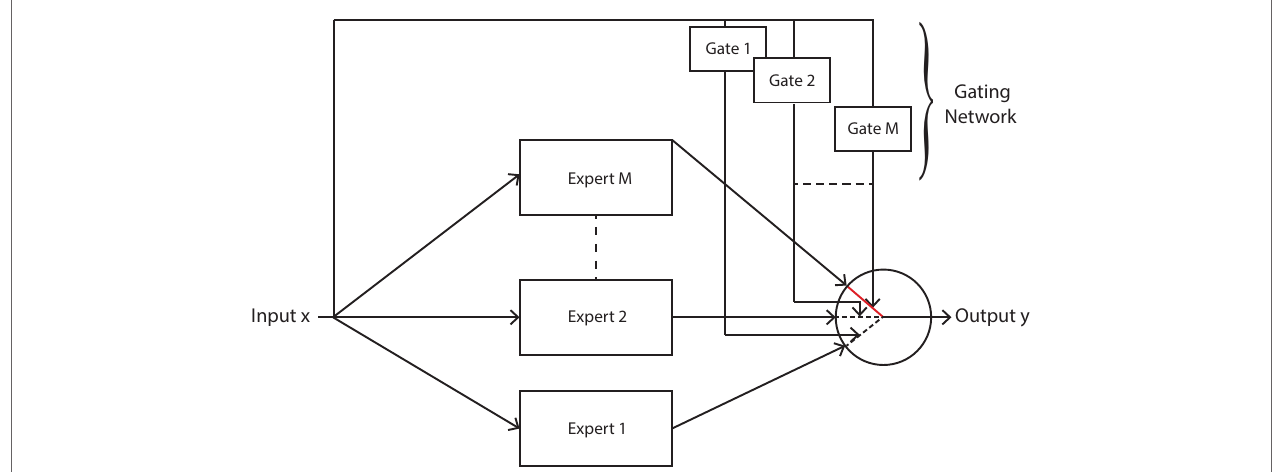
FIGURE 2 | Mixture of experts model with soft competition, whereby only one expert is active at any given time. This expert is chosen probabilistically via the gating